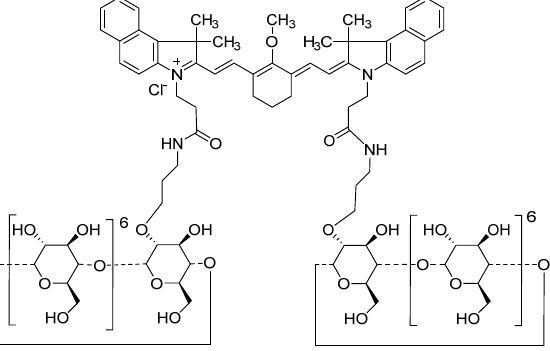
Figure 1. Chemical structure of ASP5354.